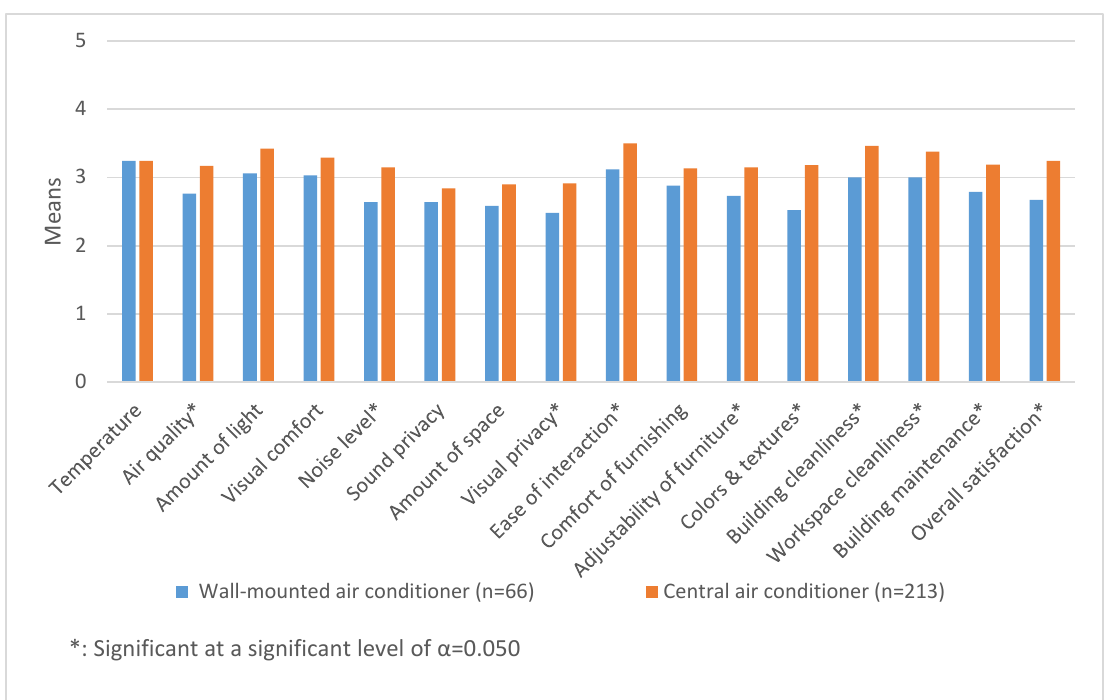
Figure 8 . The impact of proximity to window on satisfaction with IEQ factors. Figure 8. The impact of proximity to window on satisfaction with IEQ factors.